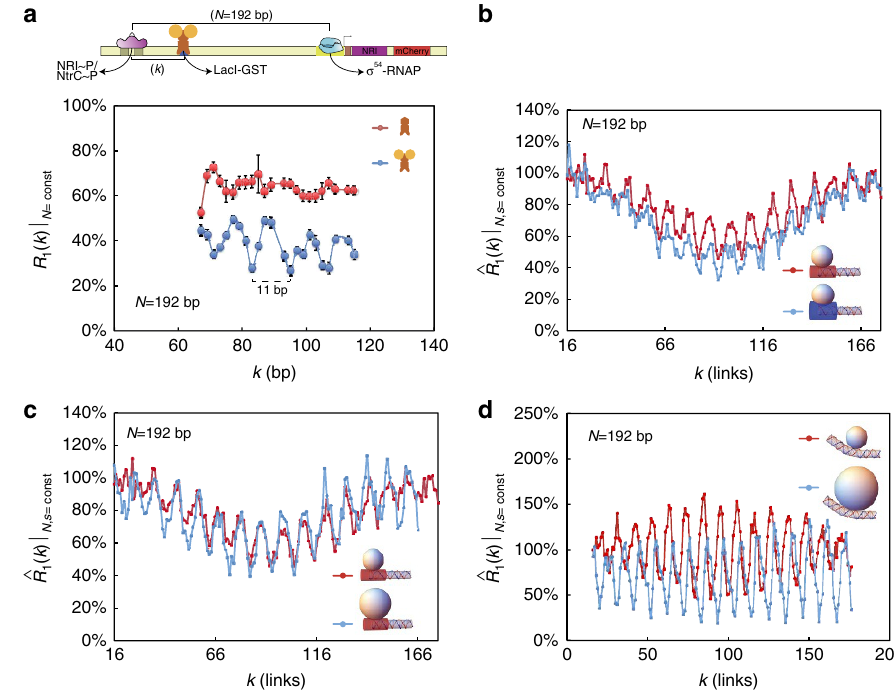
Figure 4 | Combined elastic and entropic effects on looping. ( a ) Expression-level ratio measurements for the synthetic enhancers with a single LacI- binding site. Blue and red circles correspond LacI-GSTand LacI expression-level ratios, respectively. ( b – d ) One-dimensional cross-sections for N ¼ 192 links comparing: ( b ) two values of stiffening with constant protrusion volume (blue) 2 b and (red) 1.5 b , where b is the DNA’s Kuhn length (106nm). ( c ) Two protrusion volumes (blue, 8.16nm; red, 5.44nm) at constant stiffening (1.5 b ). ( d ) Two protrusion volumes that can also bend the thick chain by 10 (cid:2) (blue, 8.16nm; red, 5.44nm). Error bars correspond to the s.d. from multiple